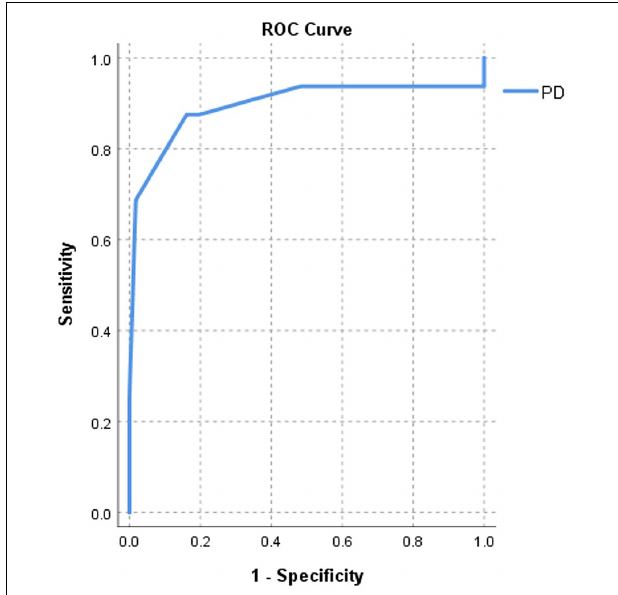
FIGURE 4 | Area under curve (AUC)-based C-statistics for new-onset AF for Pd (AUC = 0.89) in HCM patients with LAD < 45